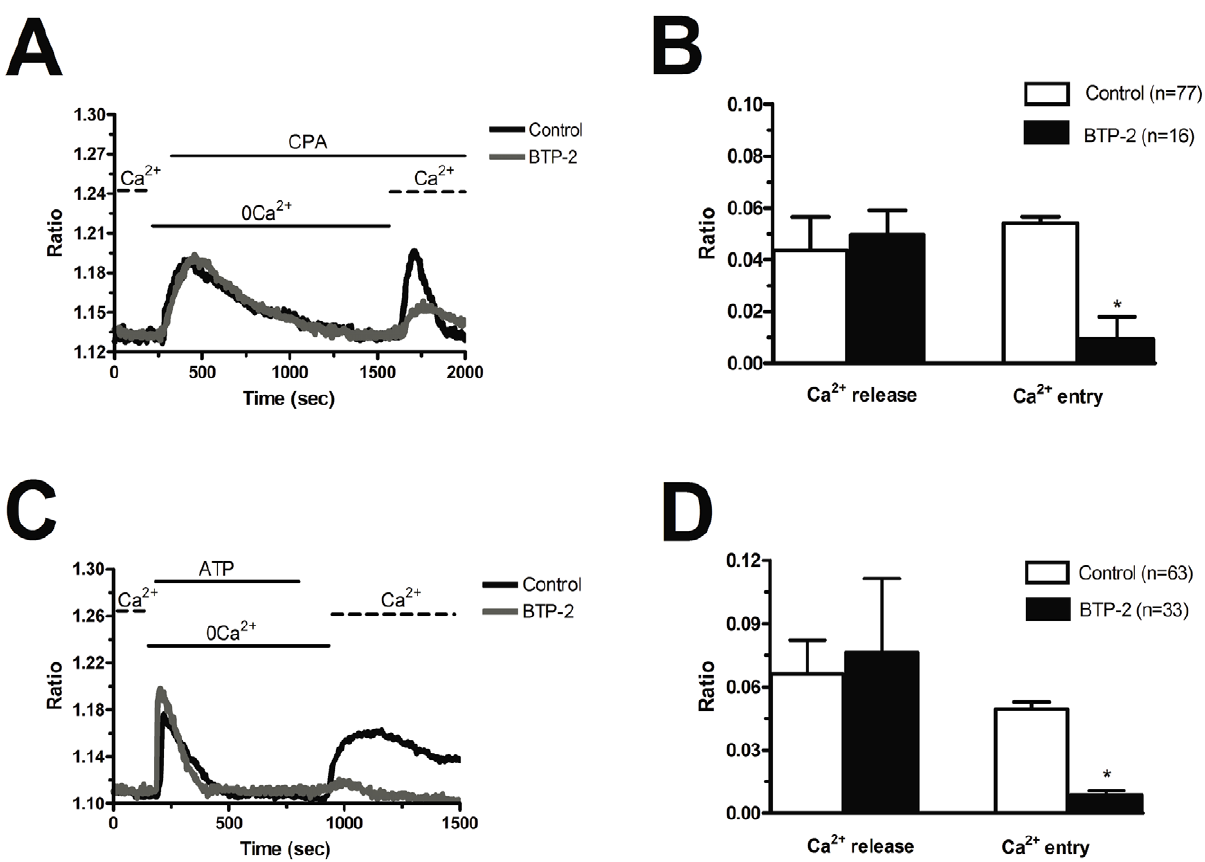
Figure 5. BTP-2 inhibits store-dependent Ca 2 + entry in endothelial progenitor cells isolated from patients suffering from renal cellular carcinoma. A, CPA-elicited SOCE in the absence (black tracing) and presence (grey tracing) of BTP-2 (20 m M). The cells were pre-incubated with the drug for 20 min before the beginning of the experimental protocol. CPA was administered at 10 m M. B, mean 6 SE of the amplitude of CPA- induced Ca 2 + release and CPA-induced SOCE in the absence and presence of BTP-2. The asterisk indicates p , 0.05. C, ATP-evoked Ca 2 + mobilization and SOCE in the presence (black tracing) and absence (grey tracing) of BTP-2 (20 m M, 20 min of pre-treatment). ATP was applied at 100 m M. D, mean 6 SE of the amplitude of CPA-induced Ca 2 + release and CPA-induced SOCE in the absence and presence of BTP-2. The asterisk indicates p , 0.05.